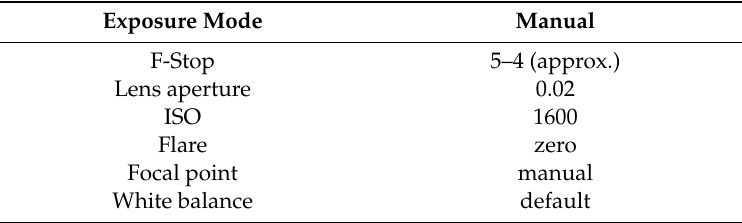
Table 2. Canon A620 camera settings to capture VELscope ®